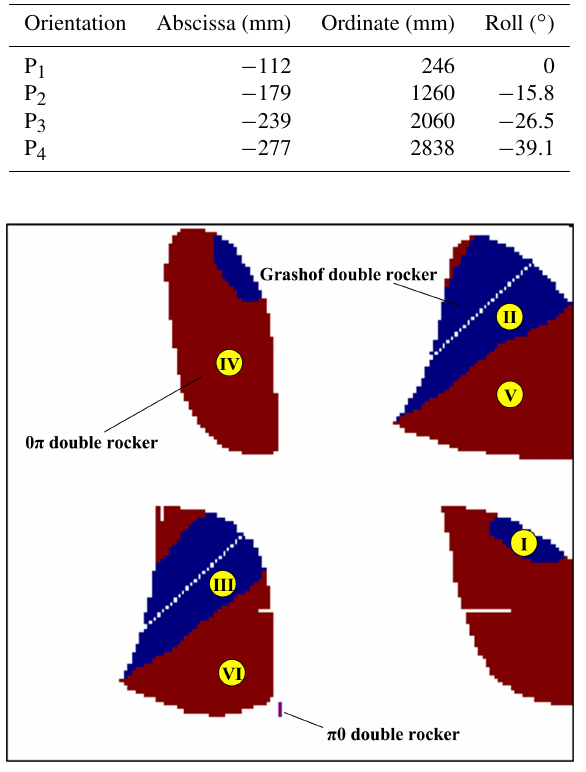
Figure 12. Solutions map generated by the program